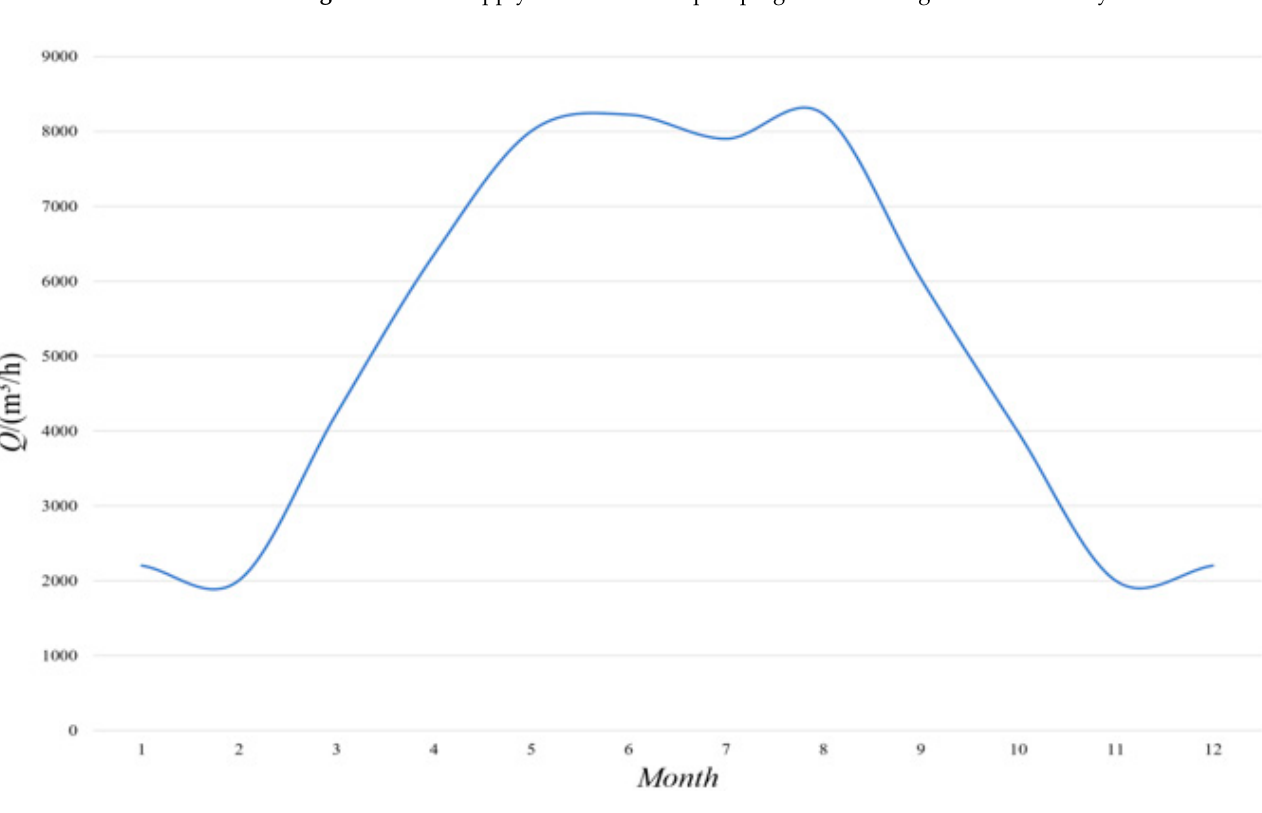
Figure 6. Annual water consumption pattern of the pumping station.